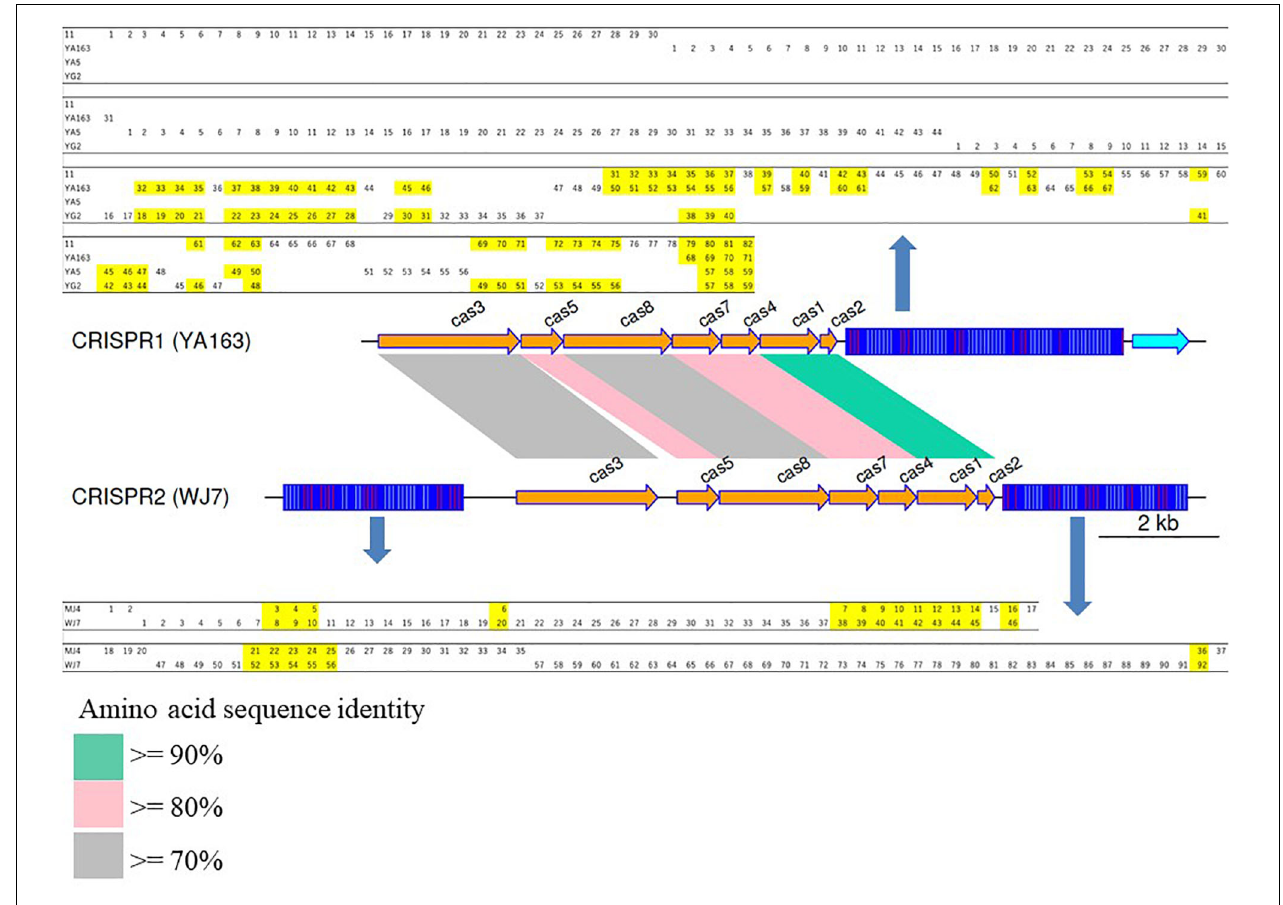
Supplementary Table 2 . CRISPR arrays with certainty scores ≥ 0.75 were considered true CRISPR arrays in the CRISPRidentify package (Mitrofanov et al., 2021). The cas genes were predicted with CRISPRidentify package and CRISPRCasFinder server, and results produced using the CRISPRidentify package are summarized in Supplementary Table 3 (Mitrofanov et al., 2021). All spacer sequences are shown in Supplementary Table 4 .